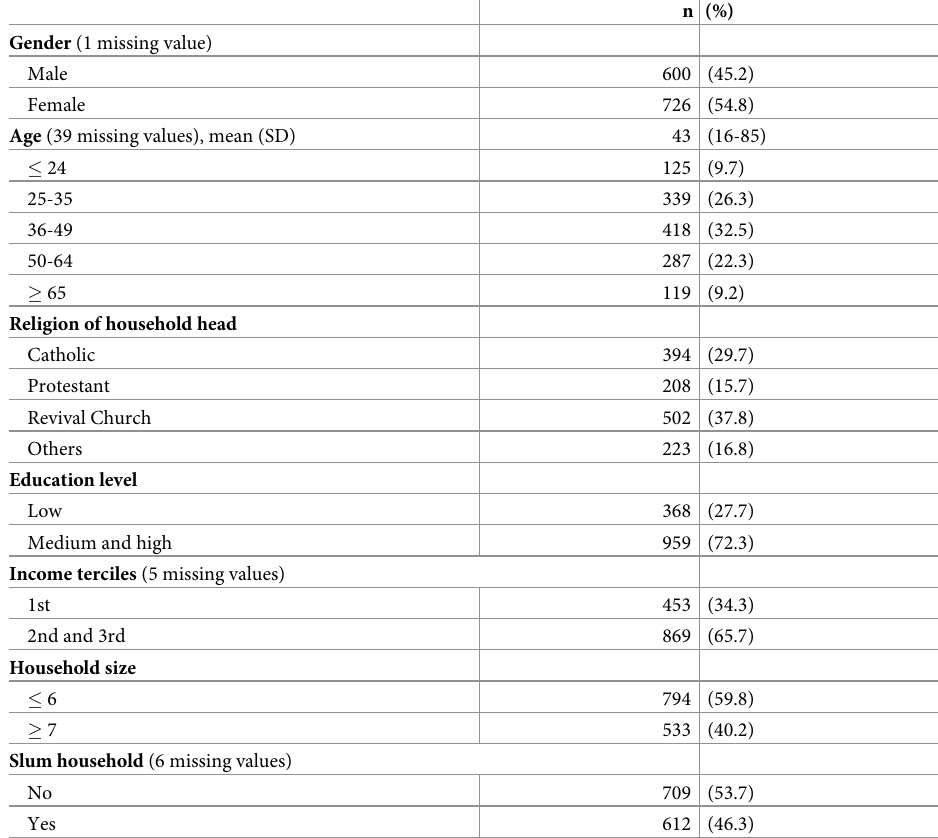
Table 1. Baseline characteristics of